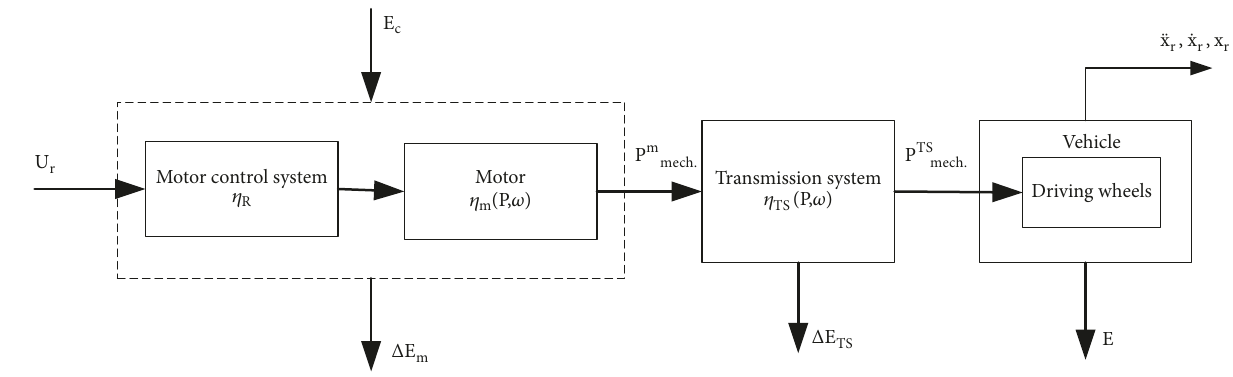
Figure 3: Functional diagram of an electric